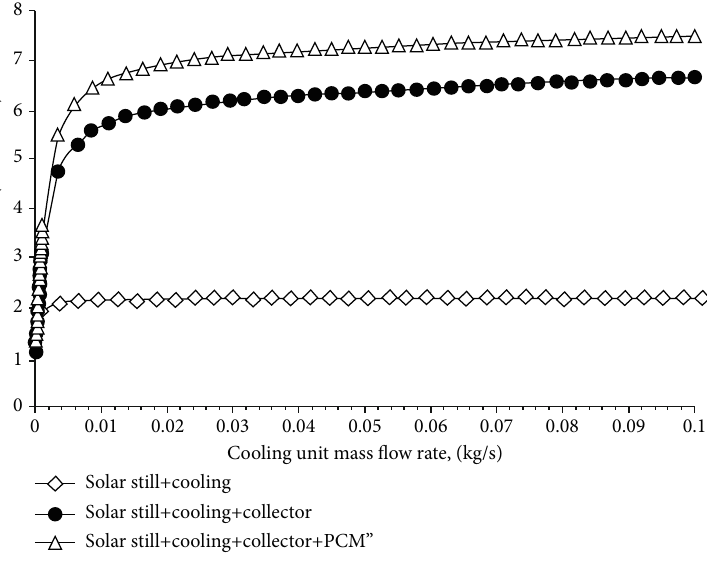
Figure 23: Cooling mass fl ow rate e ff ect on the productivity [15].